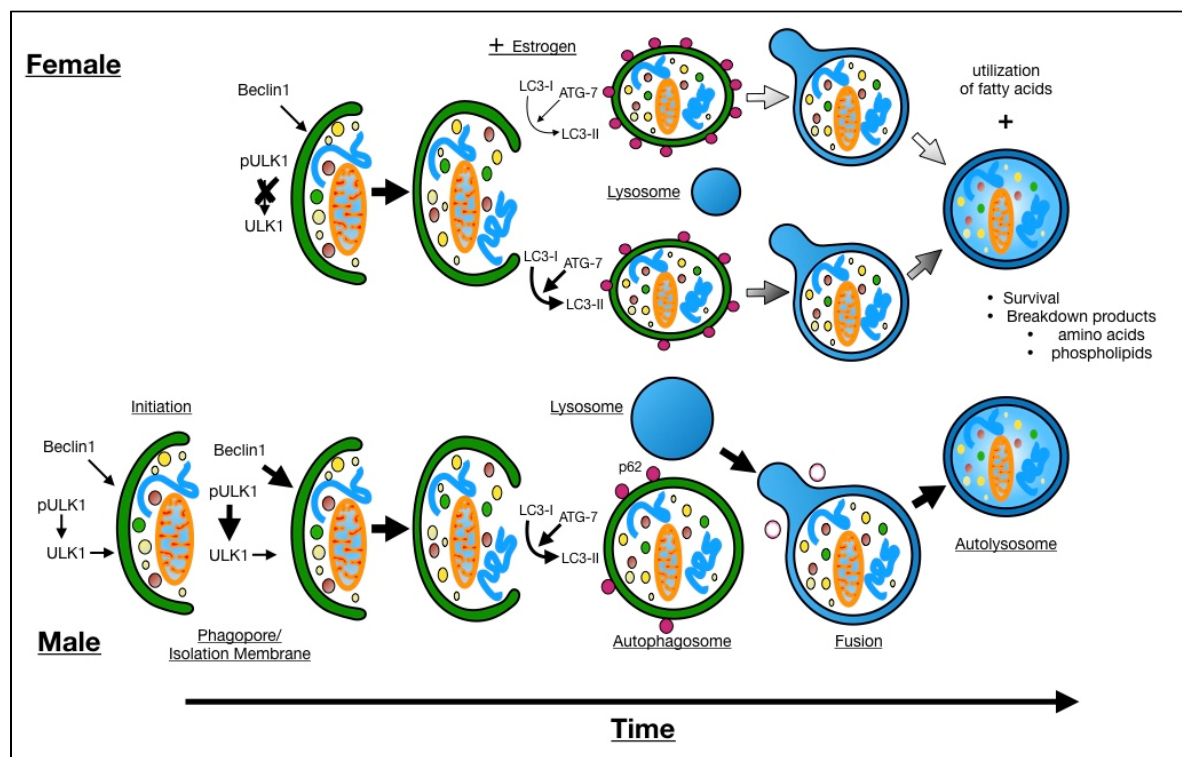
Figure 6. Schematic of sex differences in the autophagy pathway. Supplementary Materials: The following are available online at www.mdpi.com/xxx/s1, Figure S1: Sex-specific cultures of primary neurons, Figure S2: LC3 levels in the brains of mice 72 h of MCAO, Figure S3: Co-localization of p62 and LC3 in neurons in the peri-infarct cortical region, Figure S4: Neuronal survival in male and female neurons 0 h and 120 h subjected to normoxia or OGD with or without E2. Author Contributions: A.N.P., A.R.P., V.R.V. and J.L. performed animal surgeries, A.N.P., A.R.P. performed protein analysis. J.F.M.-M. performed in vitro studies and data analysis. L.M.O. per- formed. S.J.D. performed protein analysis. A.R.P. contributed to histological analysis of brain tis- sue. A.S.T. edited the manuscript. L.D.M. oversaw all experiments and edited the manuscript. All authors have read and agreed to the published version of the manuscript. Funding: This work was supported by the National Institute of Neurological Disorders and Stroke R01NS055215/R0NS108779 (to L.D.M. and F.L.), R01NS078446 (to J.L.), as well as TL1TR000369 (to ANP). Institutional Review Board Statement: This study was conducted according to the guidelines of the Declaration of Helsinki, and approved by the University of Connecticut Health Center Institu- tional Animal Care and Use Committee, protocol #100442-0515 approved on 30 August 2012. The UConn Health IACUC is committed to the humane care and use of laboratory animals. The IACUC has over sight of all animal-related activities performed at UConn Health. It is the respon- sibility of the IACUC to ensure that all work performed with research laboratory animals used at UConn Health complies with all applicable federal, state, and institutional laws, policies and guidelines. UConn Health is fully accredited by AAALAC International and has been since 21 June 1977. Our last full accreditation was given on 12 July 2019. Informed Consent Statement: Not Applicable. Data Availability Statement: The data sets generated during the current study are available from the corresponding author on reasonable request. Conflicts of Interest: The authors declare they have no competing interests. Abbreviations